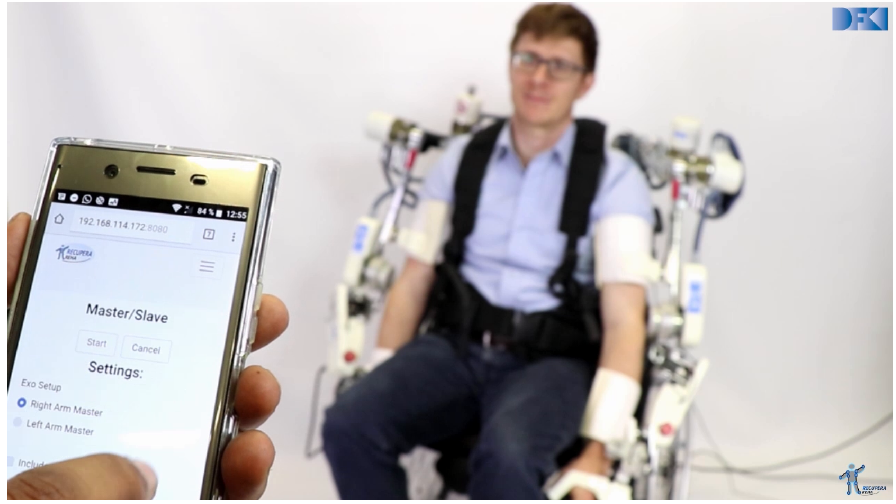
Figure 9. Web GUI for high level control.